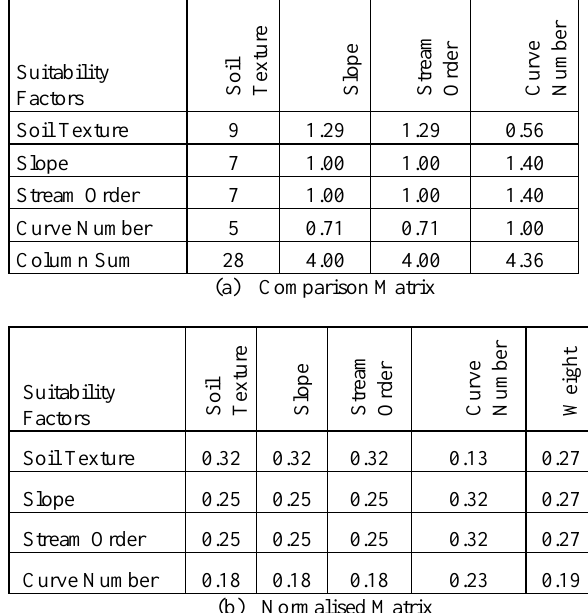
Table 3. Deriving relative weights of the suitability